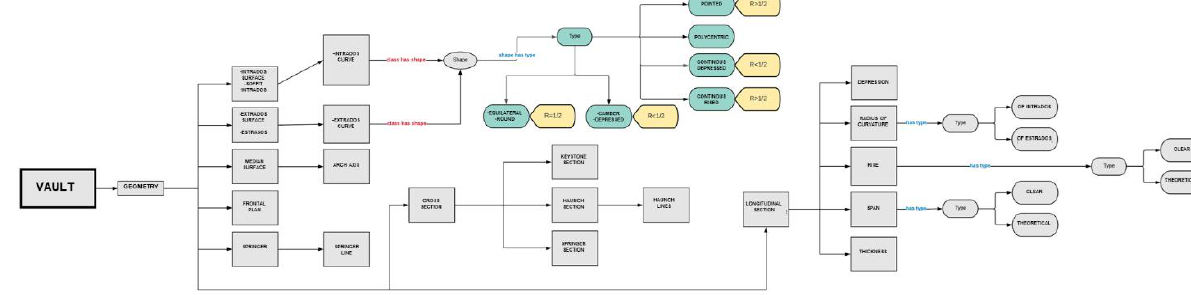
Figure 4 . Part of the conceptualization of the vault class referring to the